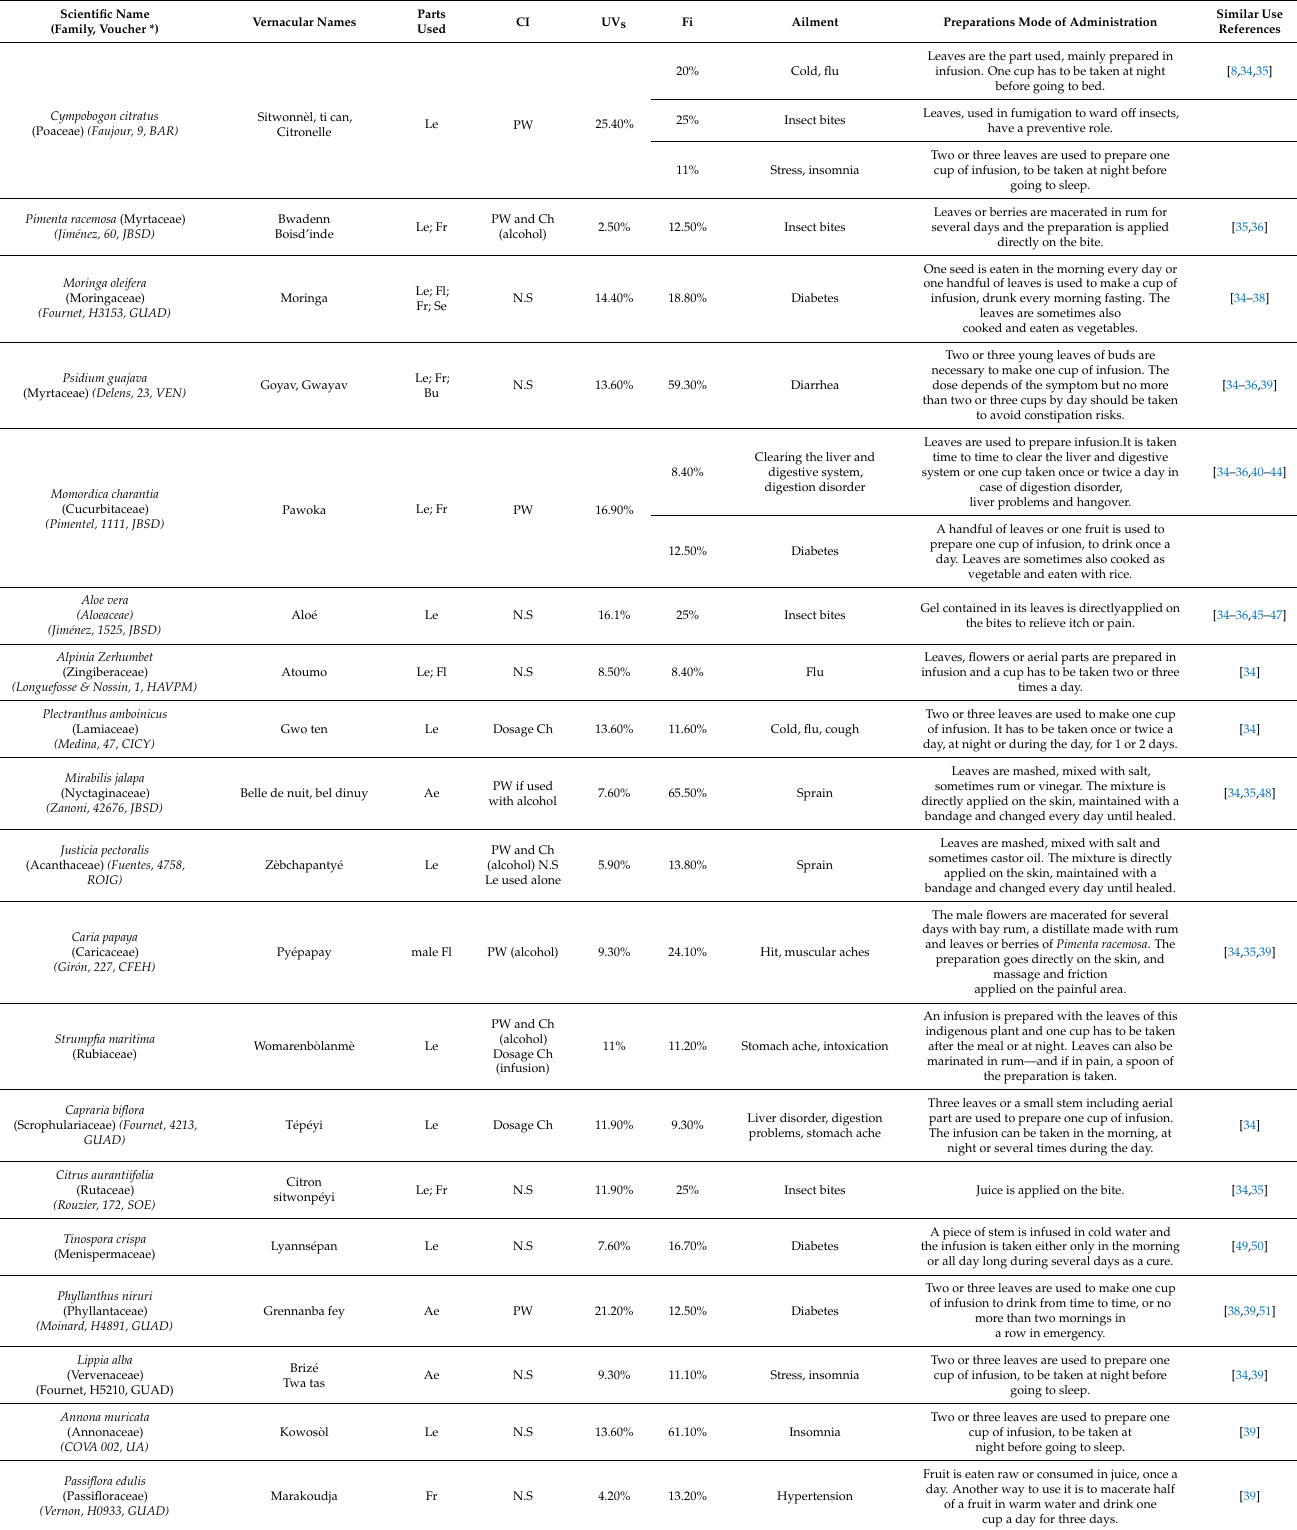
Table 2. Plant-based remedies in Grande-Terre. Le: leaves; Fl: flower; Fr: fruit; Bu: bud; Ro: root; Se: seed; Ae: aerial part; CI: contraindication (mainly for children and pregnant women); PW: pregnant woman; Ch: children; N.S: non stated. * Germos é n-Robineau, L. Pharmacop é e V é g é tale Carib é enne. 3 è me. TRAMIL.